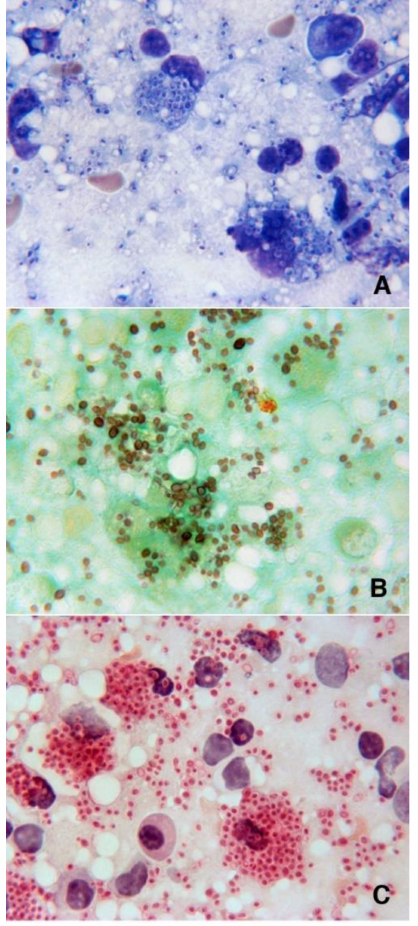
Figure 1. Imprint touch preparations from latero-cervical lymph node biopsies stained with Giemsa ( A ), Grocott ( B ), and PAS ( C ), showing intracytoplasmic capsulated microorganisms morphologically consistent with Histoplasma spp. (magnification 1000 ×